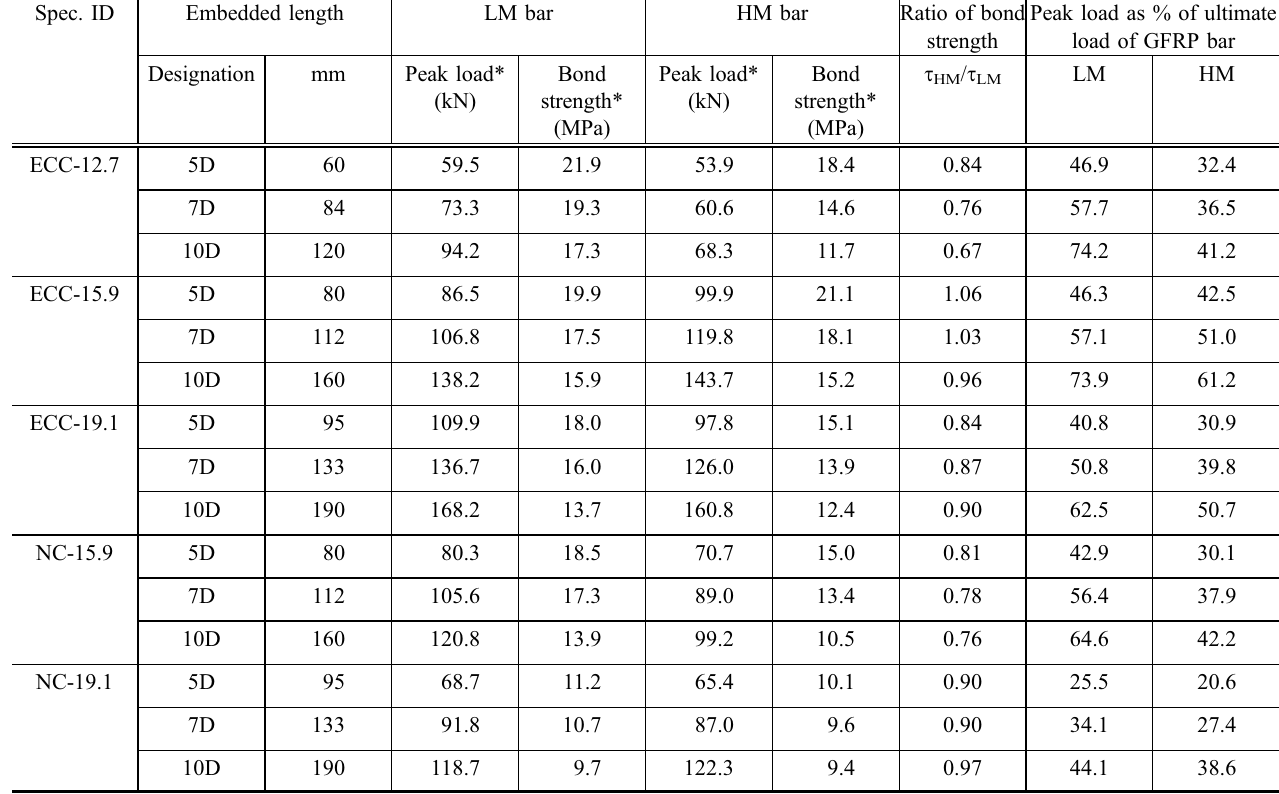
Table 4 Test results—specimen details, bar peak load and bond